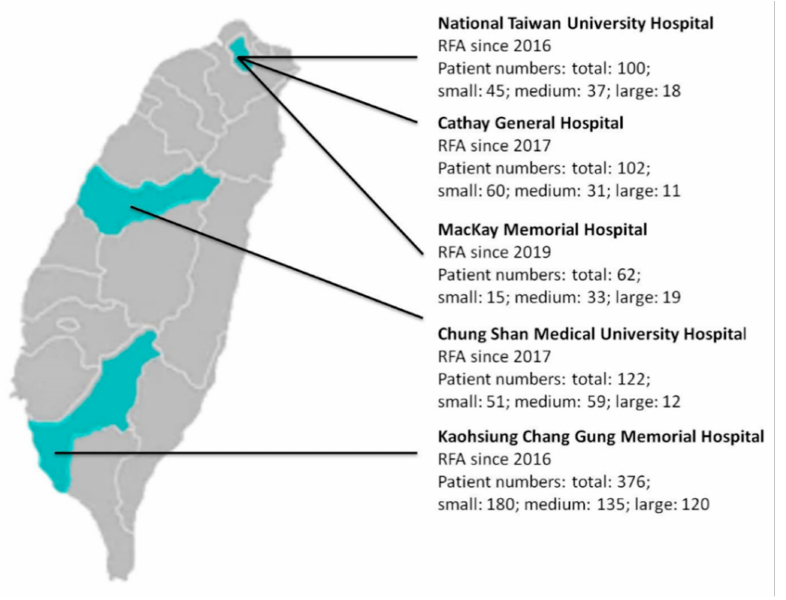
Figure 1. Participating medical